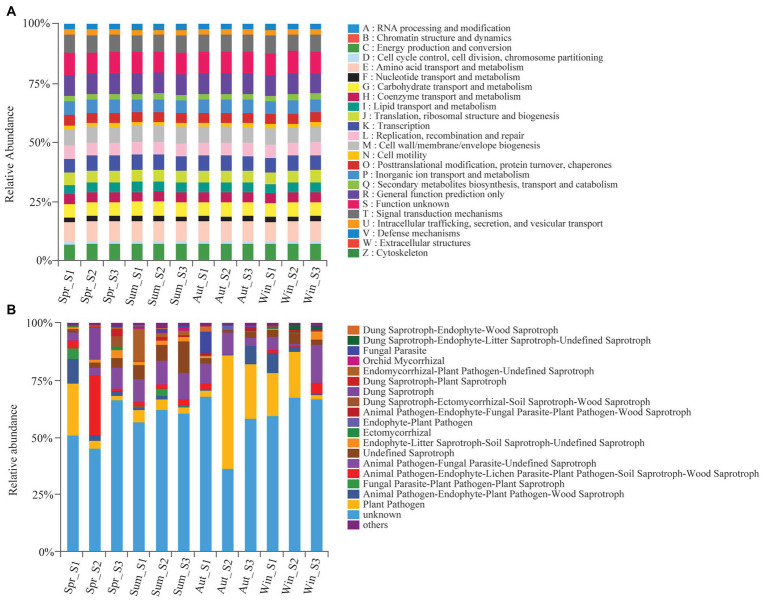
Variations in composition of bacterial (A) and fungal (B) functional groups inferred by the PICRUSt10 and FunGuild, respectively.